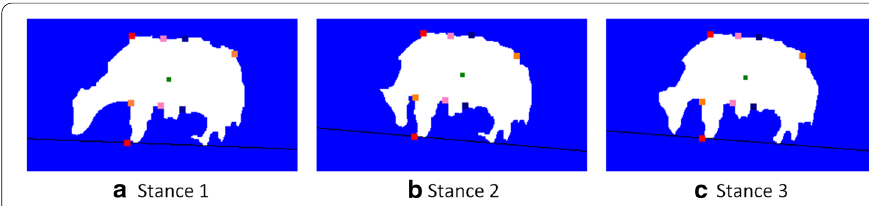
Fig. 6 Recognition images of measuring points of yak in different standing positions